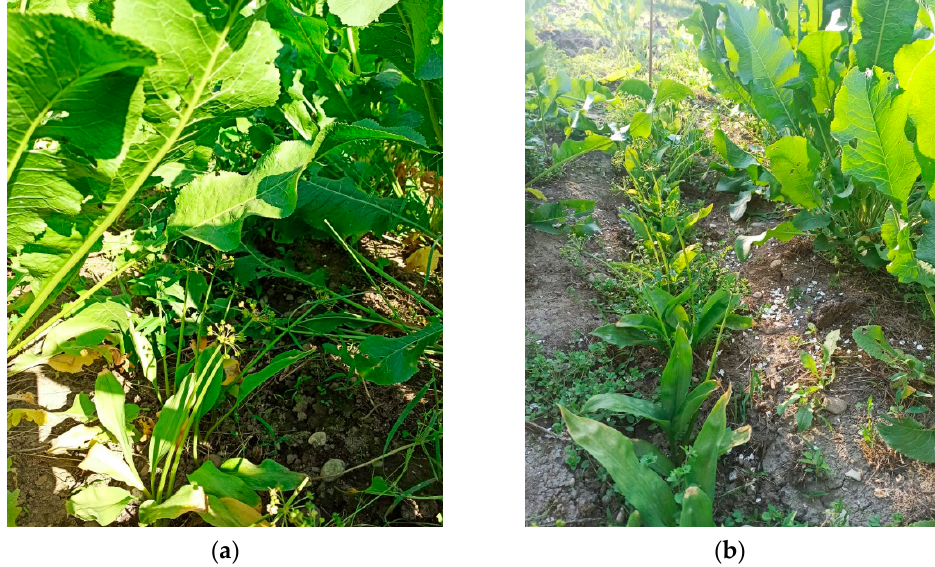
Figure 1. Experimental beds of joint ramson–horseradish cultivation: ( a ) shading effect of horseradish and ( b ) ramson appearance on experimental beds. Table 1. Morphological characteristics and yield of ramson ( Allium ursinum